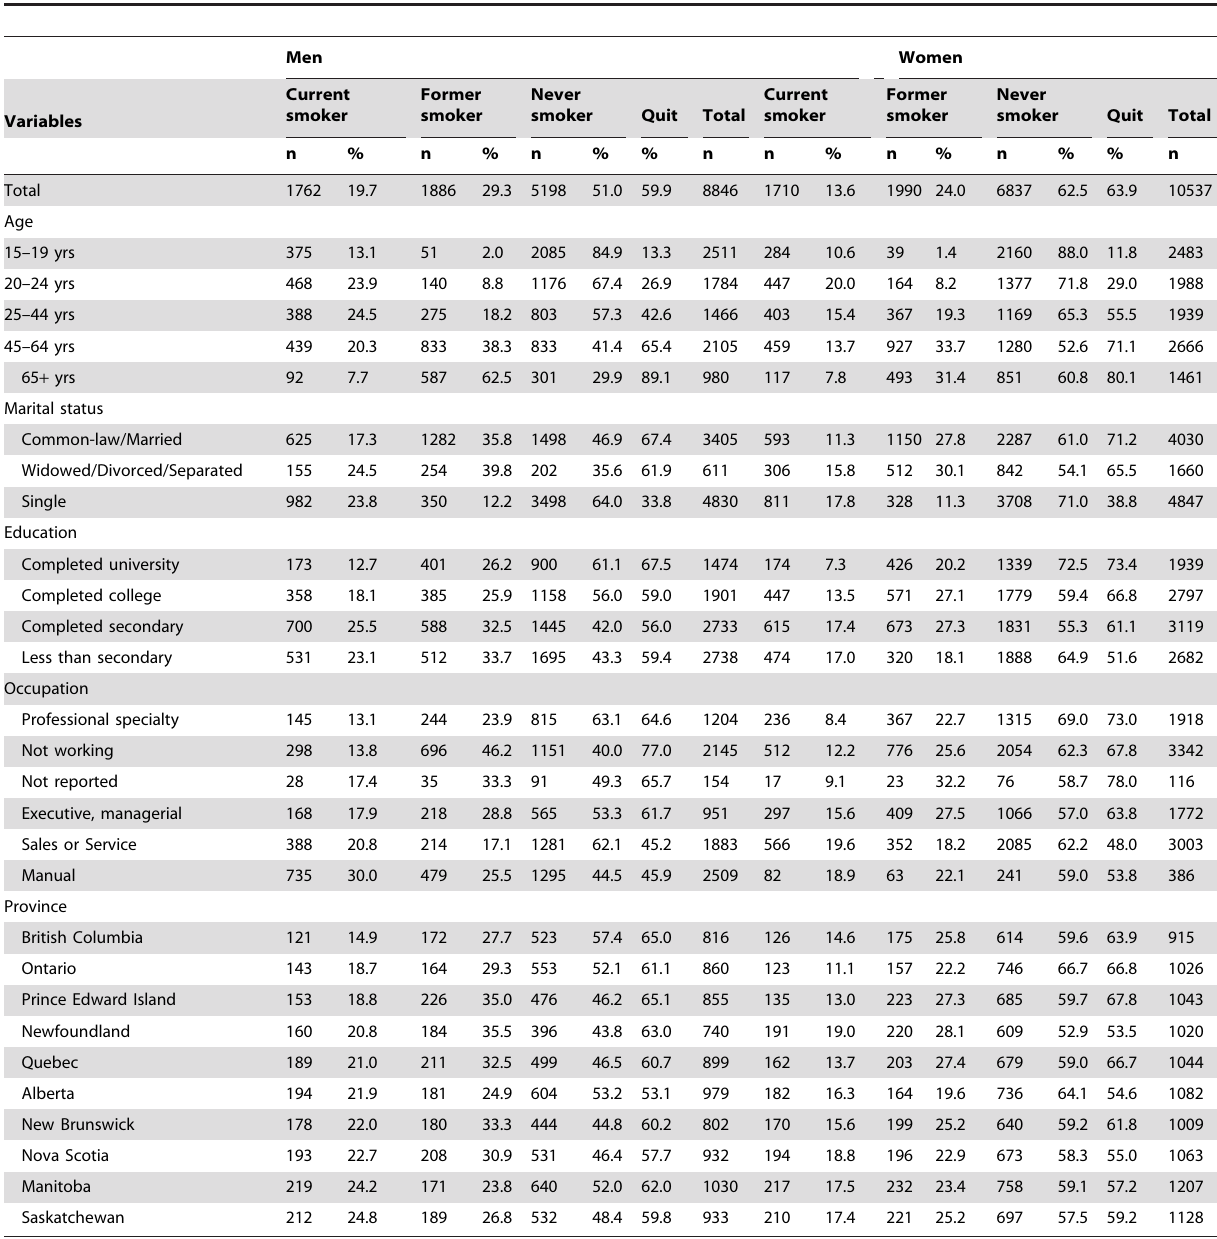
Table 1. Sample sizes and weighted estimates (%) of current smoking, former smoking, never smoking, and quitting for men and women across demographic and socioeconomic characteristics and province of